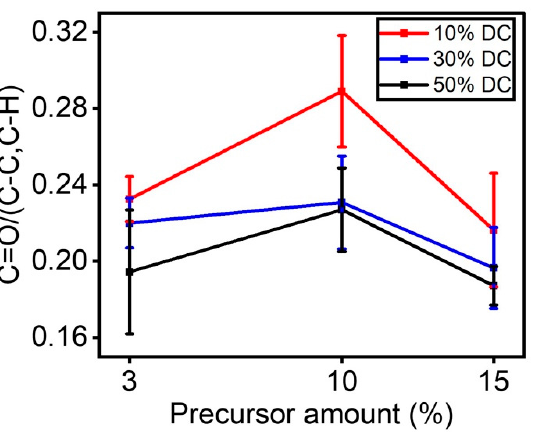
Figure 5. C=O/C-C, C-H ratio as a function of the precursor amount for each DC applied.